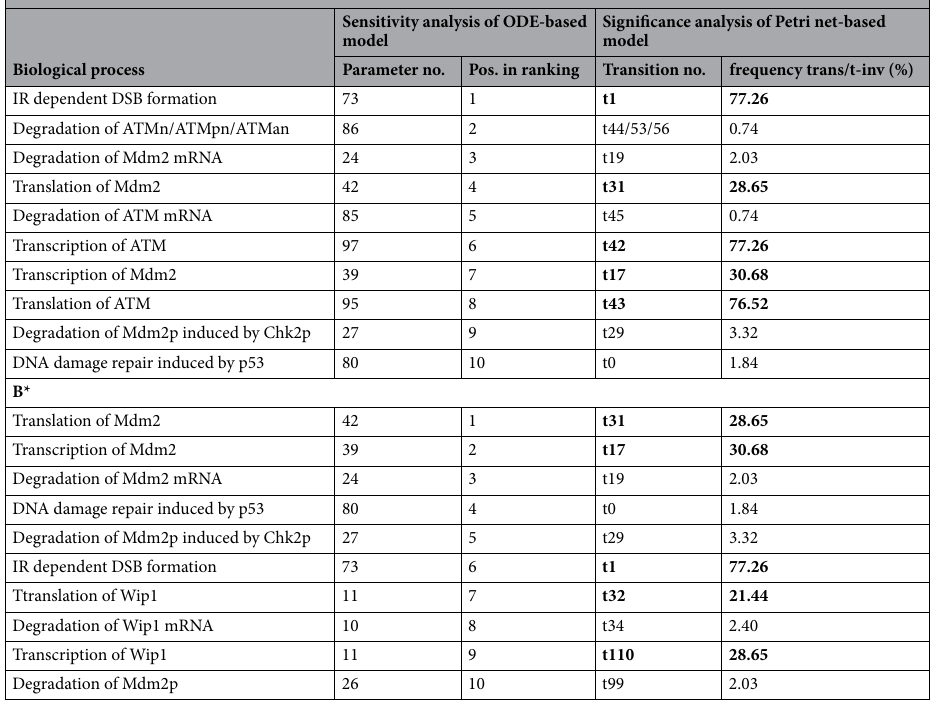
Table 2. Comparison of results of SA of ODE model (simulations with input signals ( A ) 10 µ M TNF and 4 Gy IR and ( B ) 10 µ M TNF and 10 Gy IR) and analysis of Petri net model based on the selected parameters